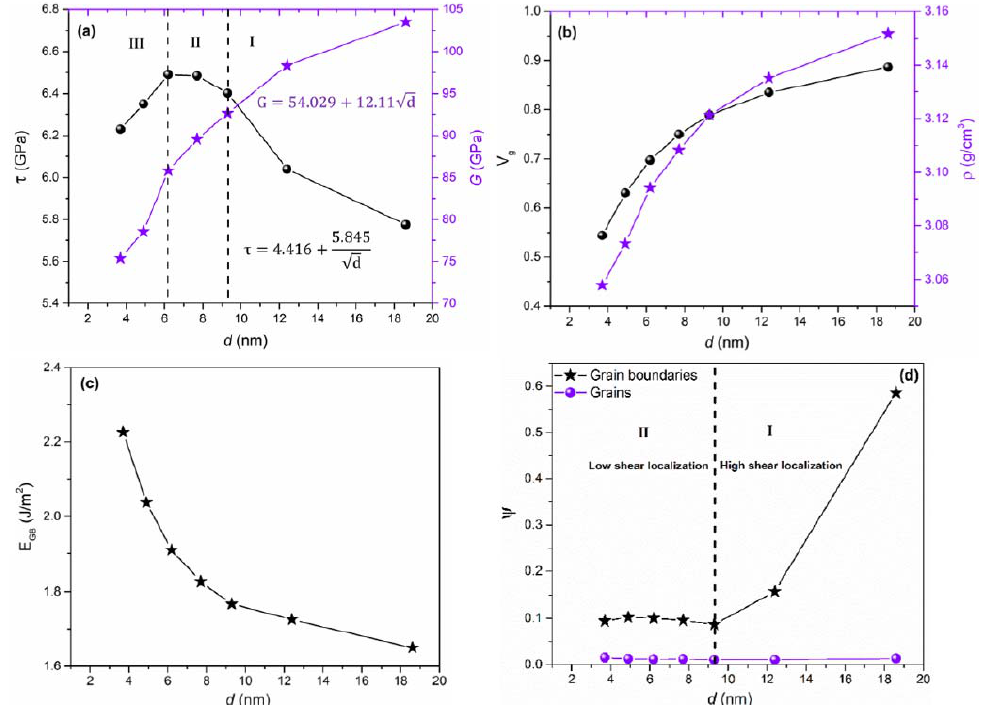
Figure 5. ( a ) Shear strength ( τ ) and modulus (G) (given in black circle and purple star respectively), ( b ) crystalline volume fraction (V g ) and density ( ρ ) (given in black circle and purple star respectively), ( c ) total grain boundary energies (E GB ), and ( d ) shear localization parameters ( ψ ) as a function of grain size. Reproduced with permission from [86]. Copyright 2022 APS.